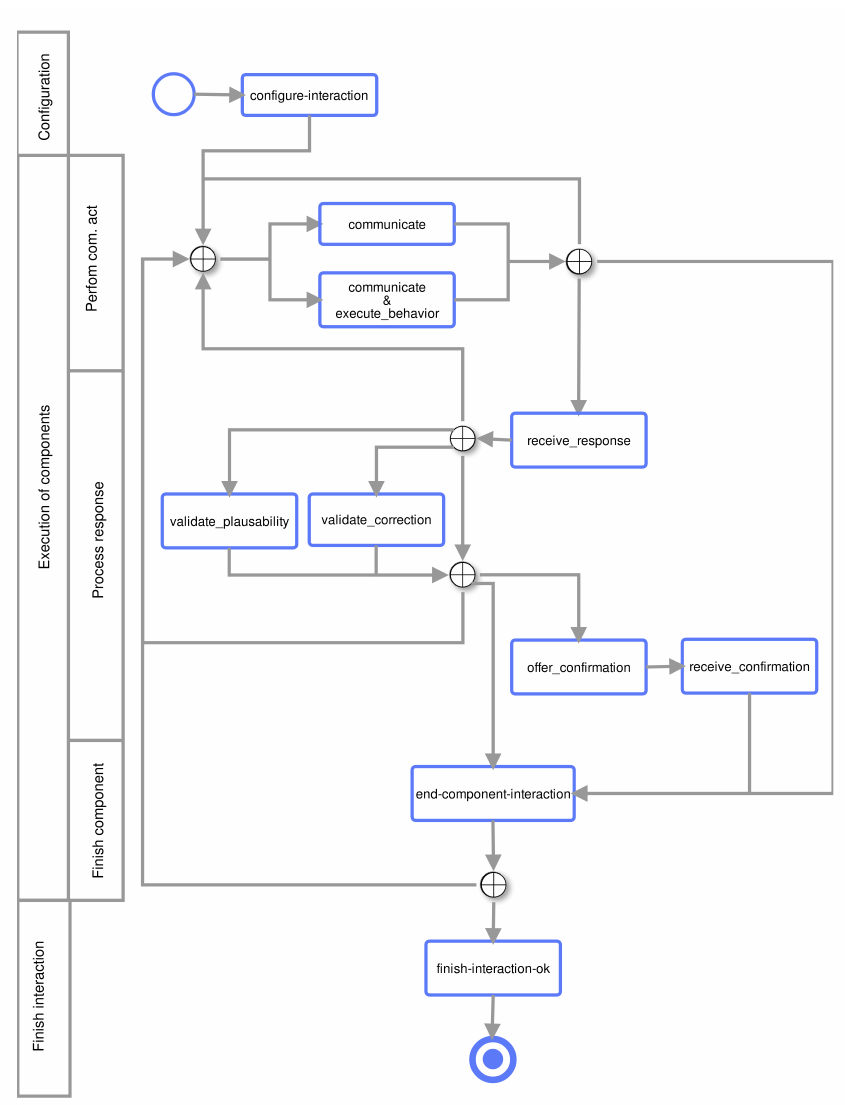
Figure 4. Nominal flow interaction